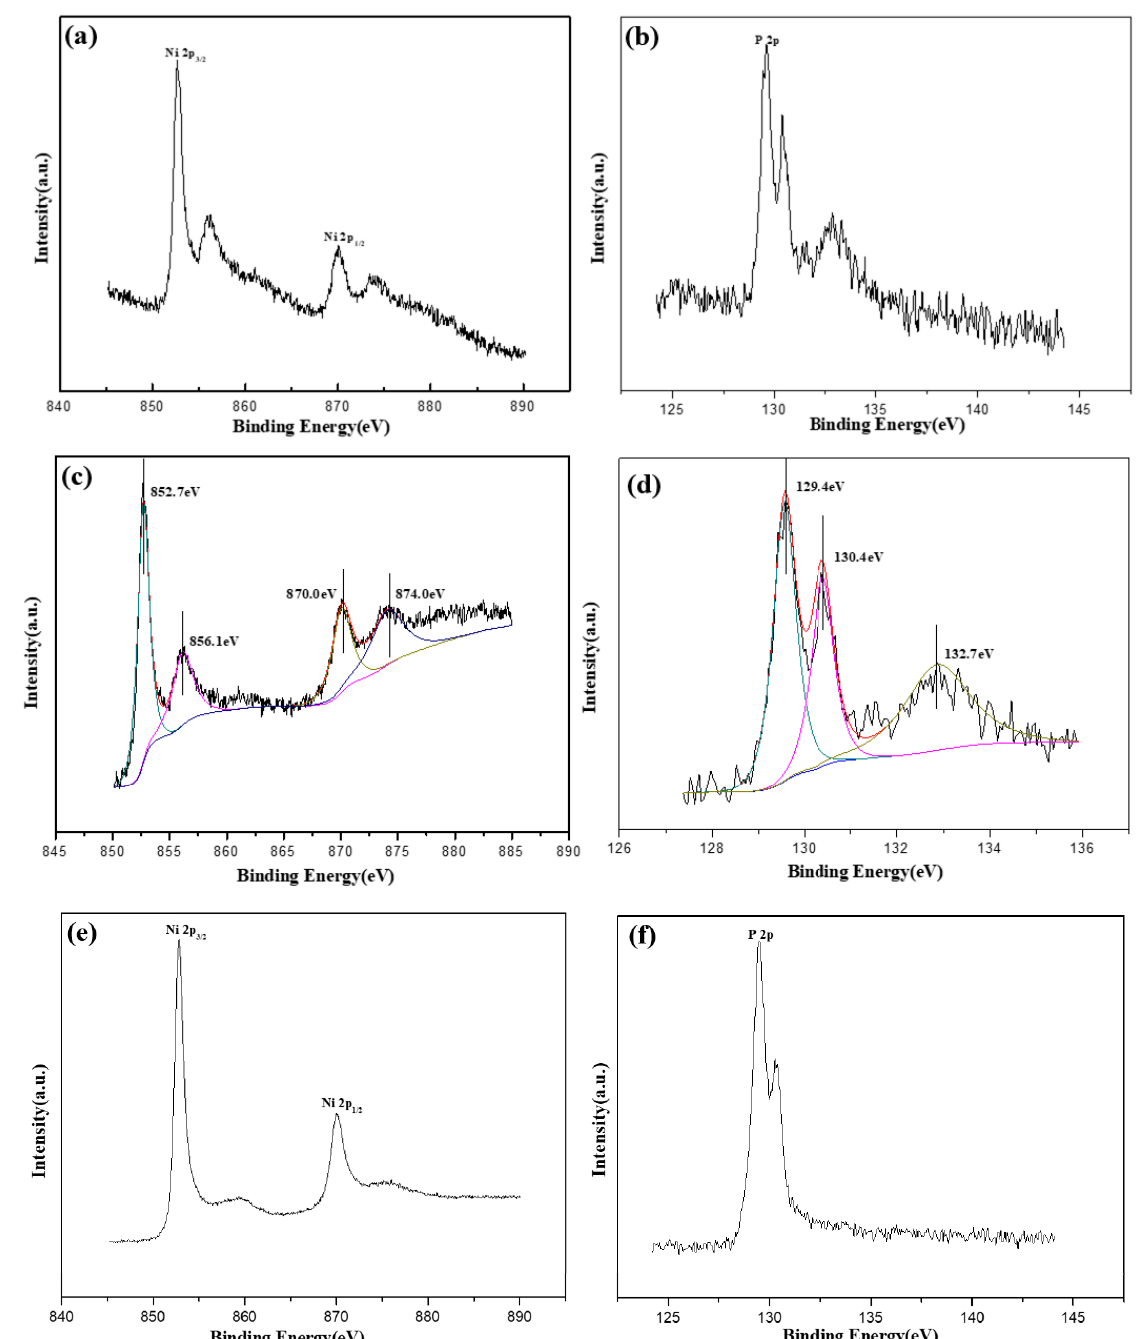
Figure 4. XPS analysis of Ni and P in electroless plated Ni-P coating: ( a ) XPS spectrum of Ni, ( b ) XPS spectrum of P, ( c ) peak-slitting processed spectrum of Ni, ( d ) peak-slitting processed spectrum of P, ( e ) XPS spectrum of Ni after etching for 30 s, and ( f ) XPS spectrum of P after etching for 30 s. XPS spectra were collected after the coating was etched for 30 s. The Ni 2p and P 2p peaks in the inner layer are shown in Figure 4e,f, respectively. The intensity of the main peak of Ni increased considerably, and the peaks at 856.1 eV and 874.0 eV disappeared,